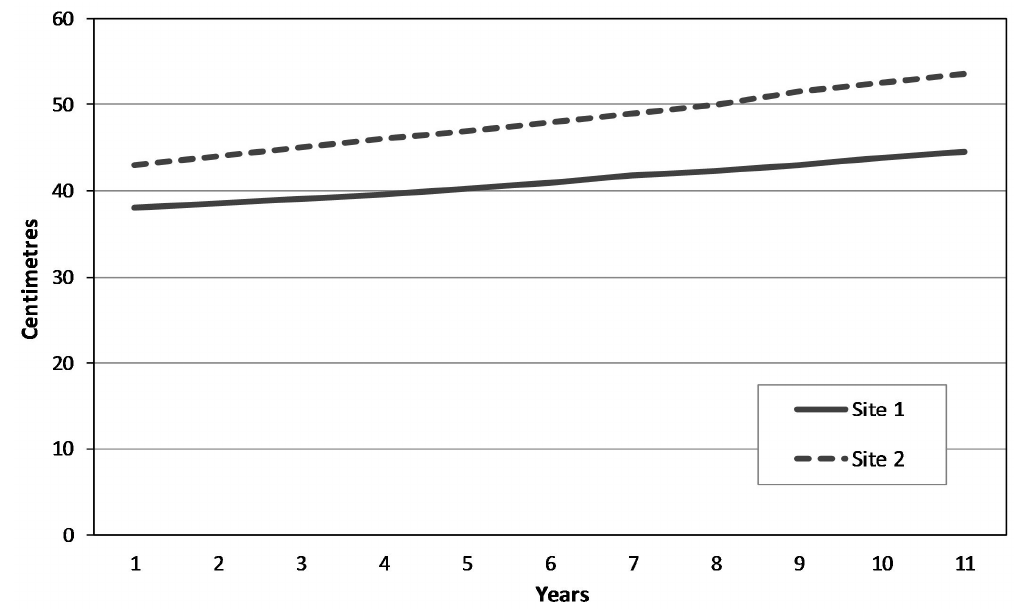
Figure 6. Prediction of changes in the tree mid ‐ diameter range (cm) of the Norway spruce stands for both study sites.